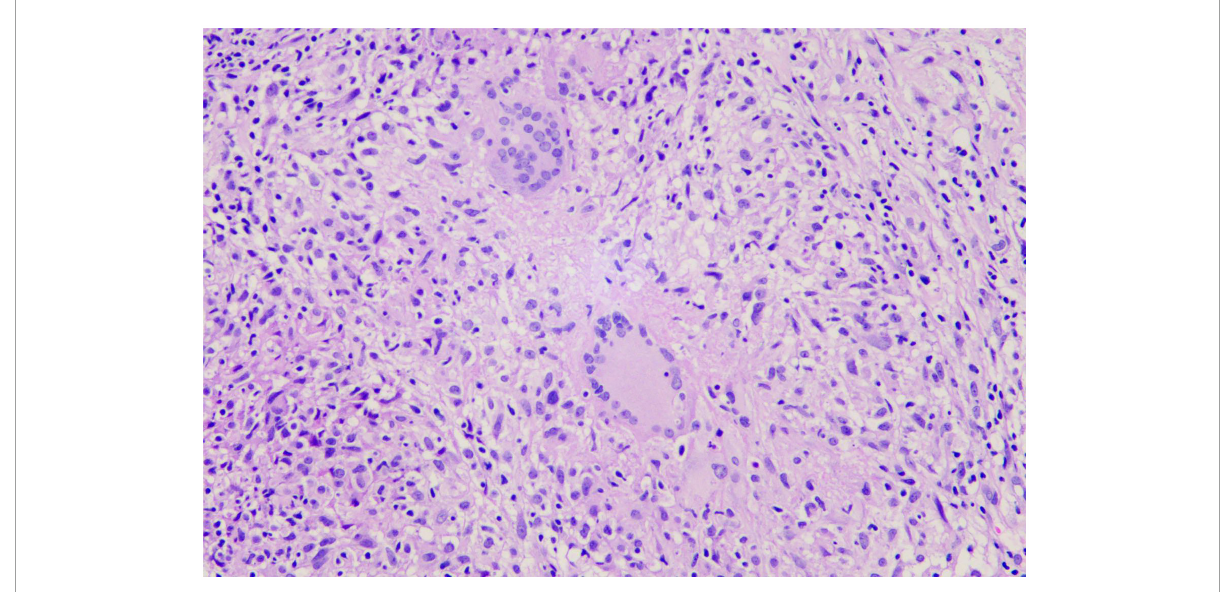
FIGURE3 Histologic finding of non-caseating granulomas (hematoxylin-eosin, original magnification × 400).